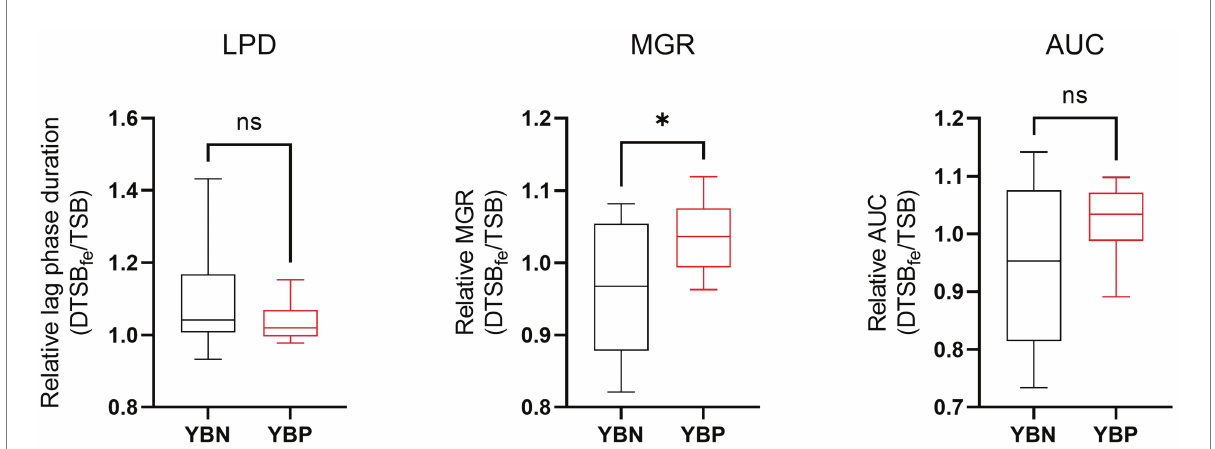
FIGURE 5 Yersiniabactin operon possession enhances growth rate under iron limited conditions in deferrated TSB media supplemented with 5 μ M ferrous Iron (DTSBfe). Box plots comparison of relative growth parameters; area under growth curve (AUC), lag phase duration (LPD), and maximum growth rate (MGR) determined under limited iron conditions (5 μ M Fe) in DTSB for the yersiniabactin negative (YBN; n = 18) and positive (YBP; n = 11) ILS S. aureus strain groups. Growth curve parameters determined under limited iron conditions (DTSBfe) were normalized to growth efficiency in normal TSB for each strain to correct for strain-dependent growth efficiency variation observed in this media. * Statistically significant differences ( P < 0.05) between the YBP and YBN groups identified using the Mann–Whitney U